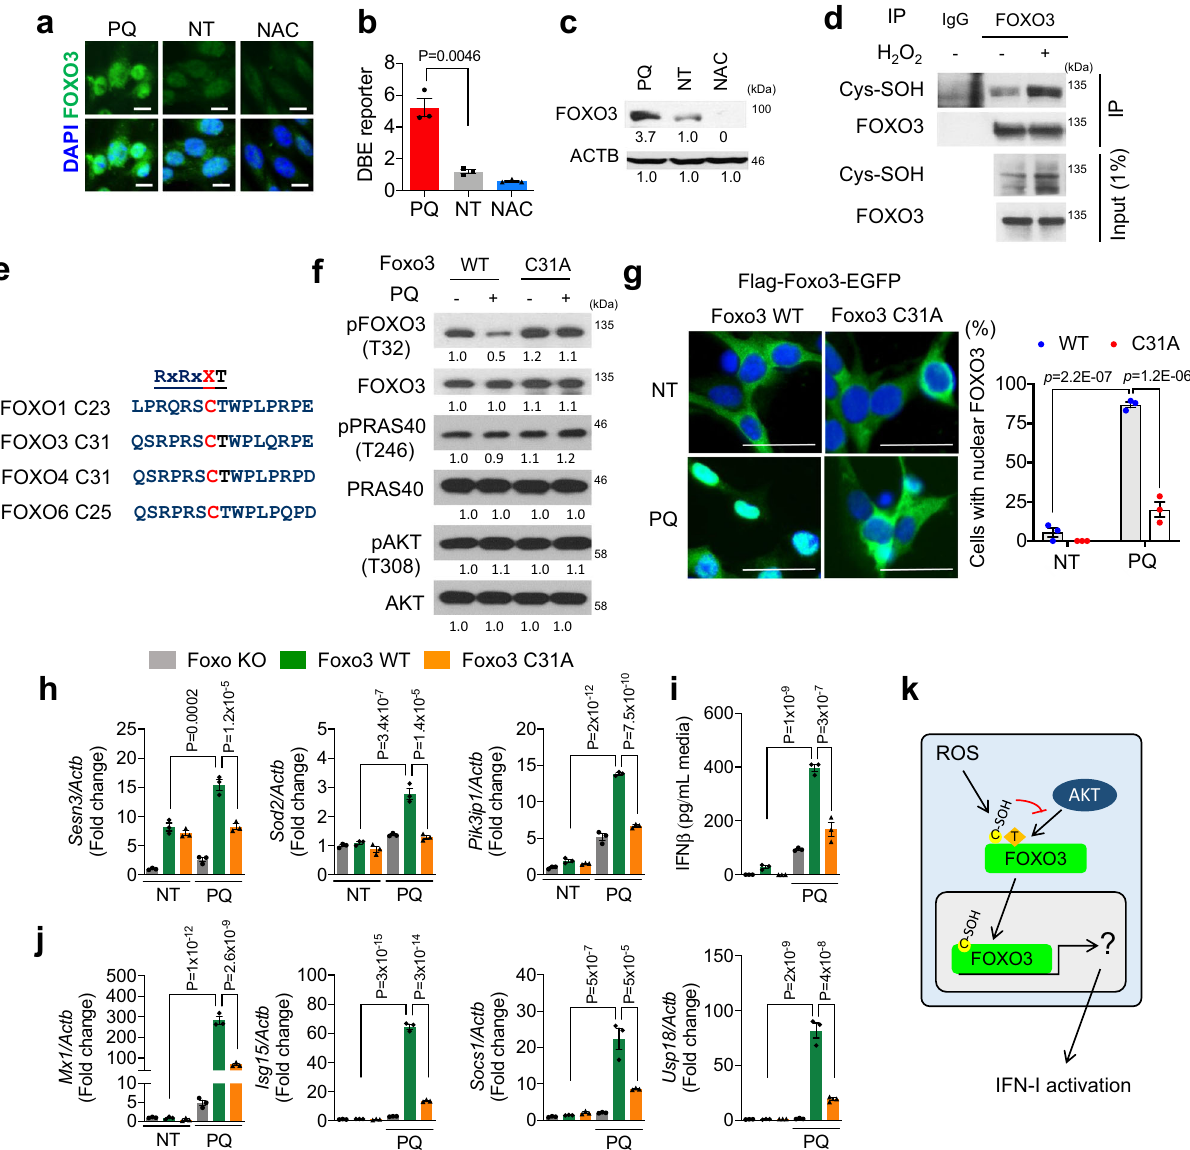
Fig. 3 Oxidation at Cys31 of FOXO3 activates IFN-I response. IF ( a ), DBE reporter ( b , mean ± s.e.m., n = 3 independent experiments), and WB ( c ) for FOXO3 in NSPCs following 24 h of respective treatment. Scale bar = 10 µ m. d WB for cysteine sulfenylation (Cys-SOH) following immunoprecipitation of FOXO3. e Conserved consensus sequence adjacent to AKT phosphorylation site of mouse FOXO proteins. f WB for indicated proteins from non-treated and PQ-treated (40 μ M, 0.5 h) Foxo3 WT or C31A mutant transduced NSPCs. g Microscopic analysis of Foxo3 WT or C31A mutant tagged with c- terminus EGFP with or without PQ treatment (40 μ M, 16 h). Scale bar = 20 µ m. Percent of cells with nuclear FOXO3-EGFP is plotted on the right. Mean ± s. e.m. of three independent experiments. qRT-PCR analysis for transcriptional targets of FOXO3 ( h ) and ISGs ( j ). Foxo null NSPCs with WT or C31A mutant Foxo3 were analyzed following 4 days of PQ treatment. Mean± s.e.m. of three independent experiments. i IFN β secretion in the media following 48 h treatment. Mean ± s.e.m. of three independent experiments. k Schema for activation of FOXO3 by oxidation at Cys31 residue. For b , g , h , i , and j , statistical signi fi cance was determined by one-way ANOVA. Experiments for a , c , d , f , and g were repeated three times independently with similar results and representative images/blots are oxidation affected AKT-dependent Thr32 phosphorylation, we conditions could also induce cysteine oxidation in FOXO3. reconstituted the FOXO3-null NSPCs with a lentiviral construct encoding green fl uorescent protein (GFP)-tagged either wild-type (WT) or Cys31 to alanine FOXO3 mutant (C31A). Immunoblot analysis showed that ROS treatment strongly reduced Thr32 phosphorylation of FOXO3 WT but not that of the C31A FOXO3 mutant, as relative to the mock-treated control cells (Fig. 3f), suggesting that oxidation at Cys31 may impede Thr32 phosphor- ylation. In line with this, fl uorescence live-imaging of GFP-tagged